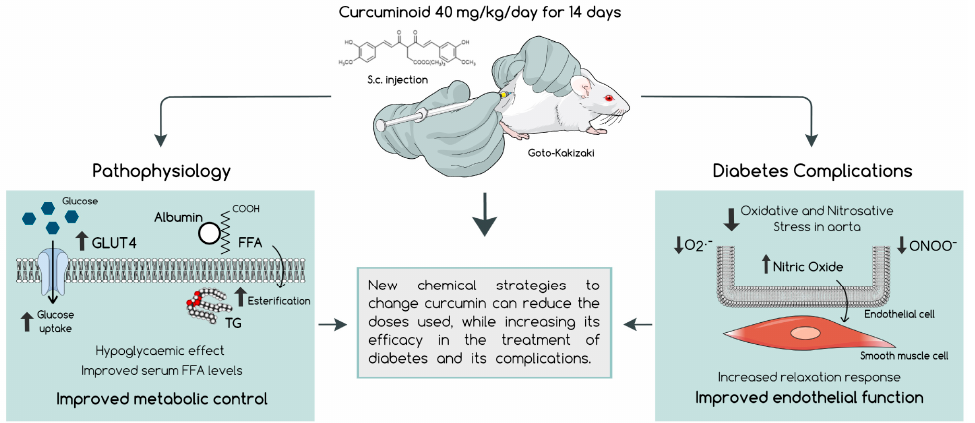
Figure 7. The curcuminoid in a low-dose regimen administered to diabetic rats for 14 days was shown to have a markedly hypoglycaemic effect, accompanied by an improvement of the lipidic profile, which promoted better metabolic control. Furthermore, this new molecule was able to enhance the relaxation response in the aorta, along with a reduction in the vascular oxidative and nitrosative stress, suggesting an improved endothelial function and vascular homeostasis, which may contribute to the prevention of diabetic complications.